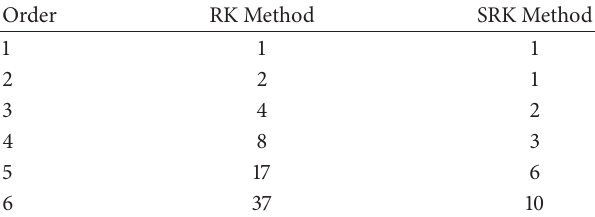
Table 1: Number of order conditions for RK and SRK to order 6. Order RK Method SRK